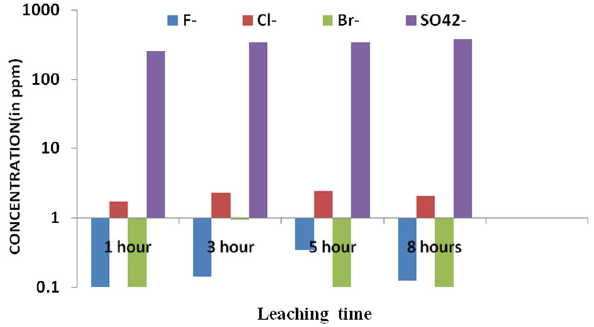
Fig. 12 Change in concentration (in ppm) of anions in aqueous leachates of Ledo coal (LC-60A) with leaching time (in hour) at 25 (cid:3) from 25 to 45 (cid:3) C however, the concentration of F - , Cl - became lower (Figs. 15, 16, 17, 18). The leaching of SO 42 - ion from coal and overburden was increased with leaching temperature from 25 to 65 (cid:3) C and time (see Figs. 15, 16, 17, 18, 19, 20, 21, 22).